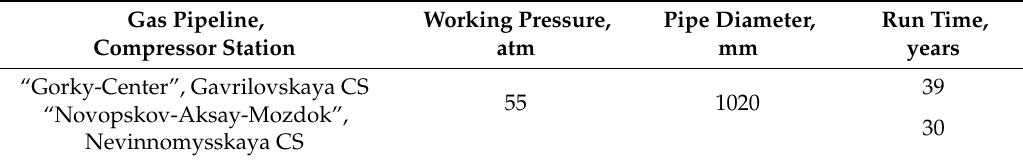
Table 1. Metal exploitation parameters of the gas